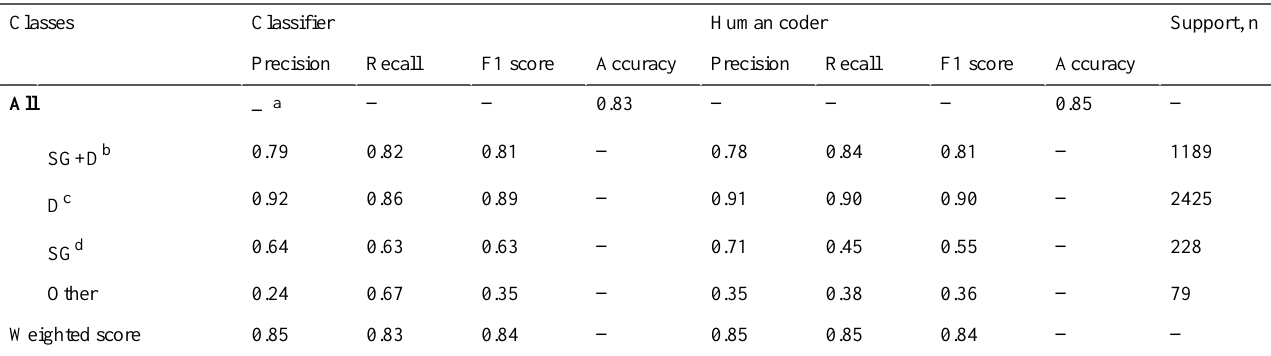
Table 2. Overall performance of the classifier.